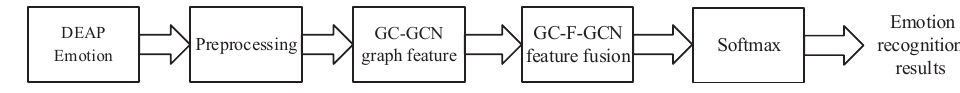
Figure 1. The framework of the proposed GC-F-GCN graph fusion feature